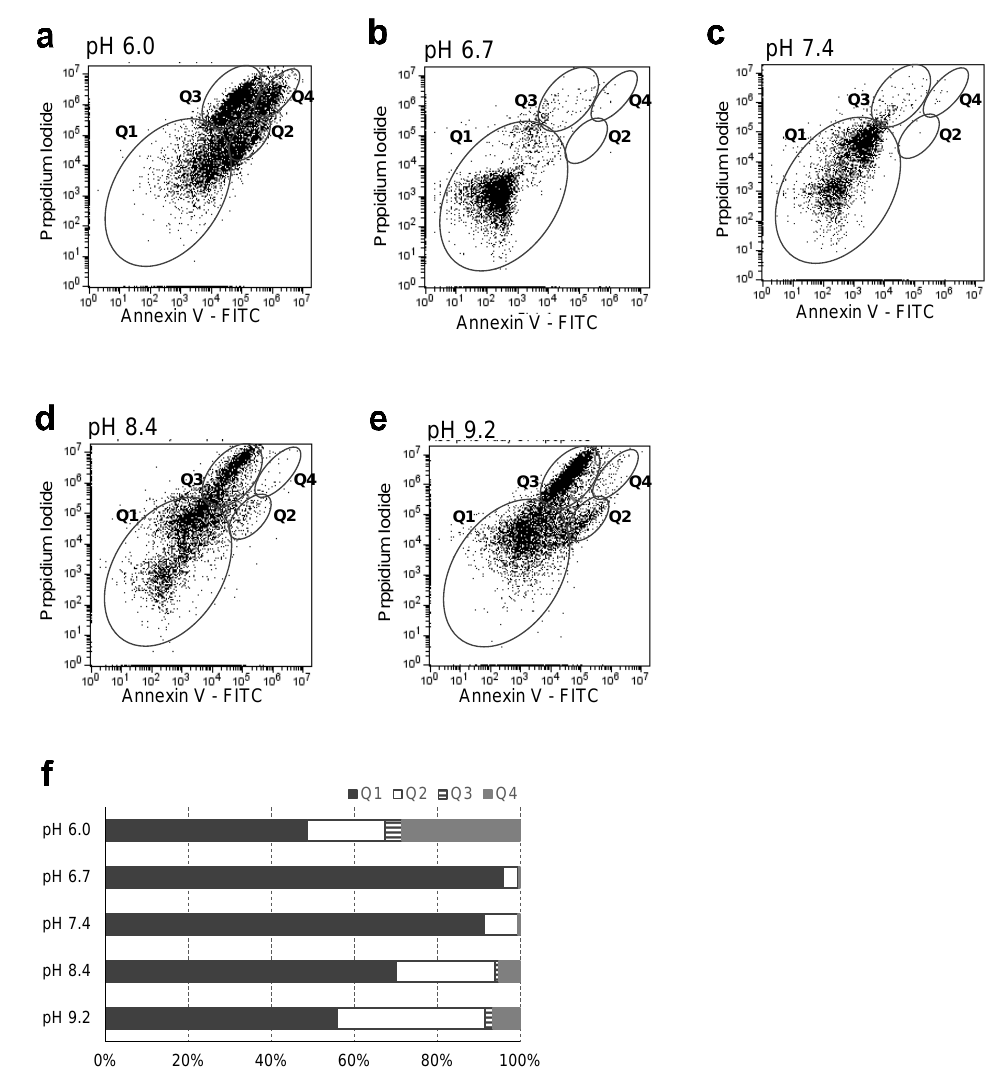
Figure 5. Apoptosis or necrosis analysis of MDA-MB-231 cells in different pHs. MDA-MB-231 cells were seeded in a 12-well plate and they were incubated at five different pHs of DMEM: ( a ) pH 6.0; ( b ) pH 6.7; ( c ) pH 7.4; ( d ) pH 8.4; and ( e ) pH 9.2. Cells were stained with Annexin V-FITC and PI, and apoptosis or necrosis was measured by flow cytometry assay. ( f ) Data in the dot plots were analyzed by Q1, Q2, Q3, and Q4.